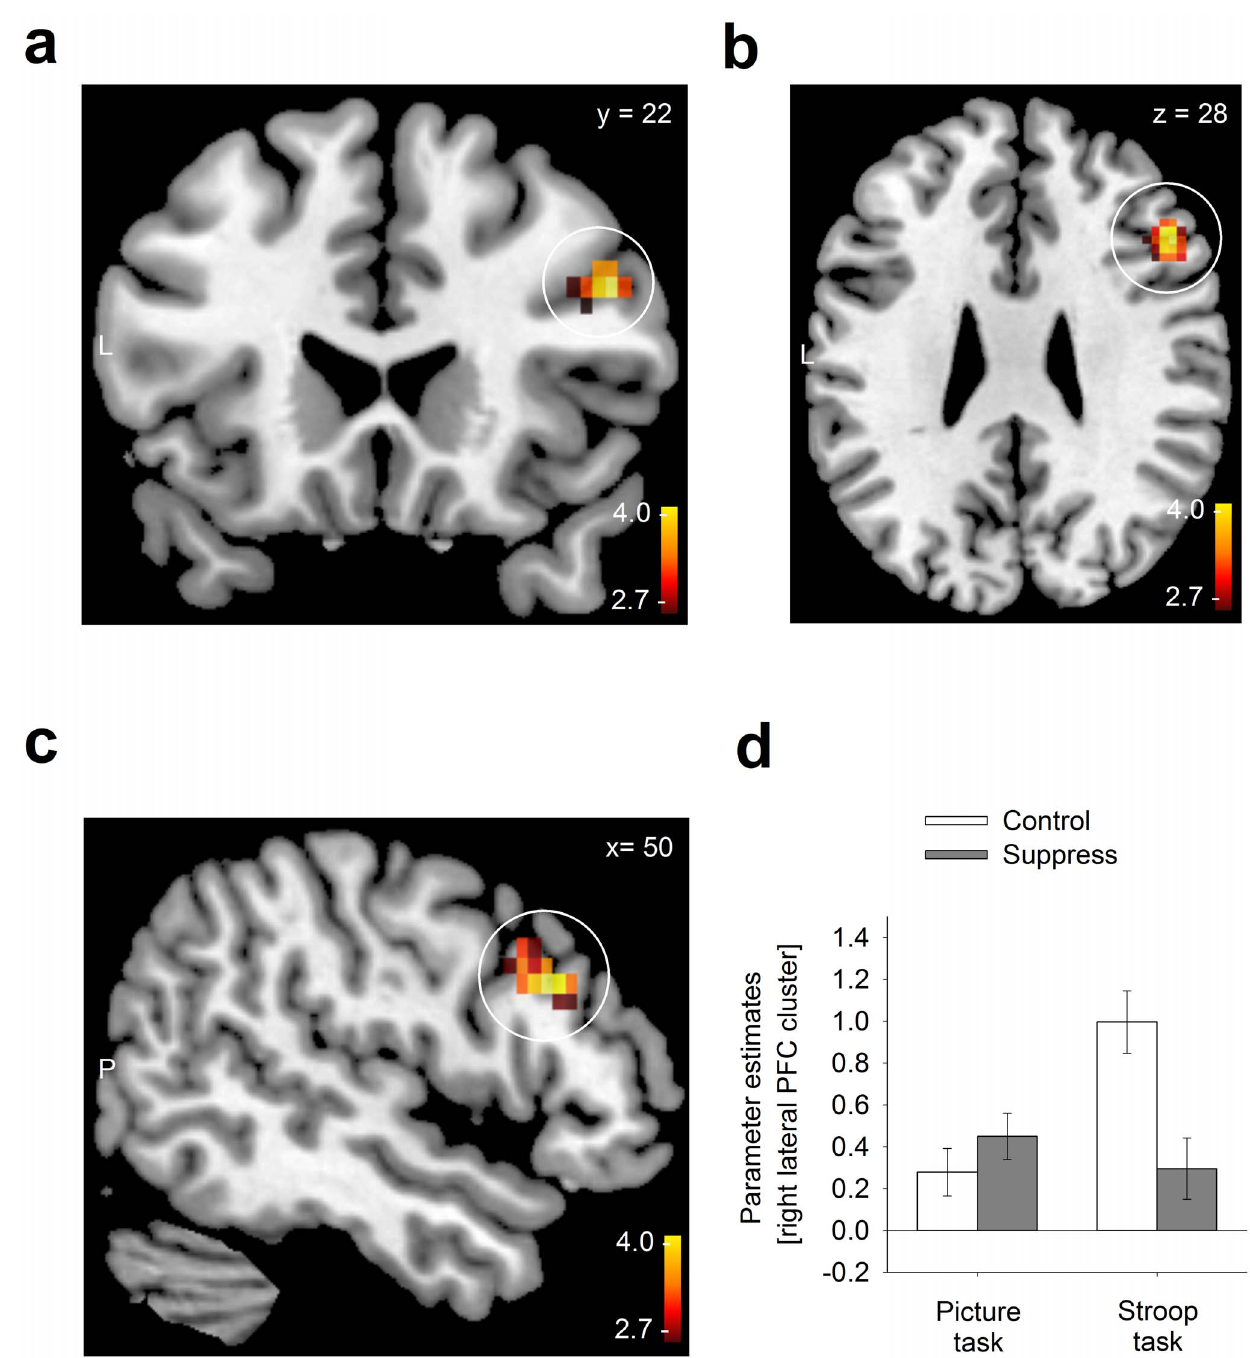
Figure 3. Aftereffects of self-control exertion on brain activity in the right lateral prefrontal cortex. (a–c) More activity in participants suppressing emotions during the picture-viewing task relative to control participants was followed by relatively less activity during the Stroop task in a cluster located in the right middle frontal gyrus (BA 9), extending into the inferior frontal gyrus (BA 9/45). t -values of the interaction contrast are color coded and displayed at a threshold of p =.005 (uncorrected) superimposed on a coronal (a), axial (b) and sagittal (c) slice of an anatomical template image. (d) Parameter estimates (arbitrary units) of the averaged activity of the right lateral PFC cluster for the experimental groups. Parameter estimates are extracted as first eigenvariate of all activated voxels in the cluster. Means 6 SE are indicated.